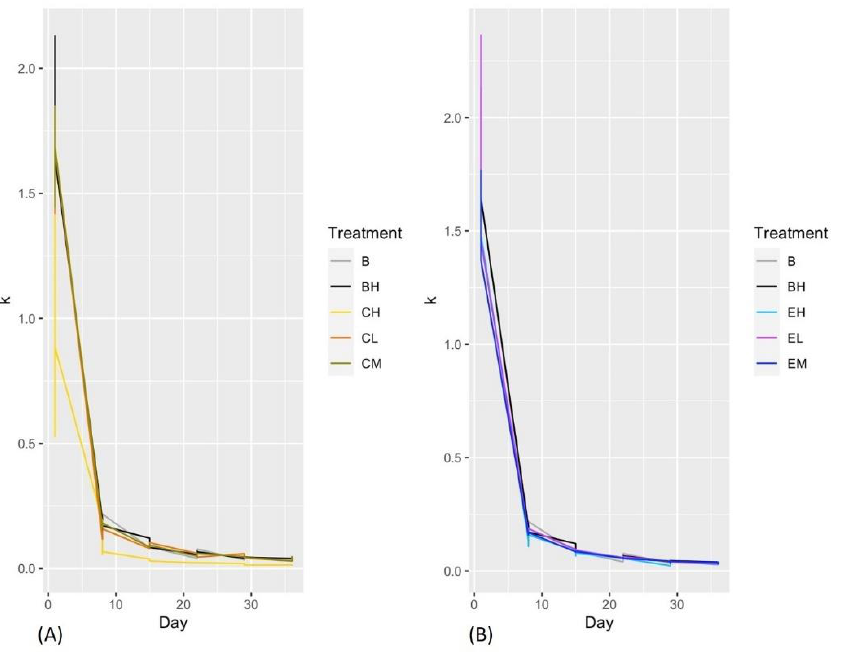
Figure 4. Decomposition rate in experiments with Chlorpyrifos ( A ) and Engeo ( B ). The letter Bin the figure legend corresponds to the experimental control without Nectopsyche sp. and BH corresponds to experimental control with Nectopsyche sp. C corresponds to Chlorpyrifos low (CL), middle (CM), and high (CH) concentrations. E corresponds to Engeo low (EL), middle (EM), and high (EH)